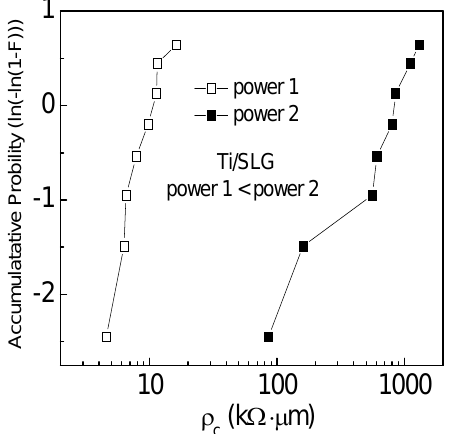
Figure 4. The distribution of the ρ different powers (power 1 < power 2). The ρ when the sputtering power